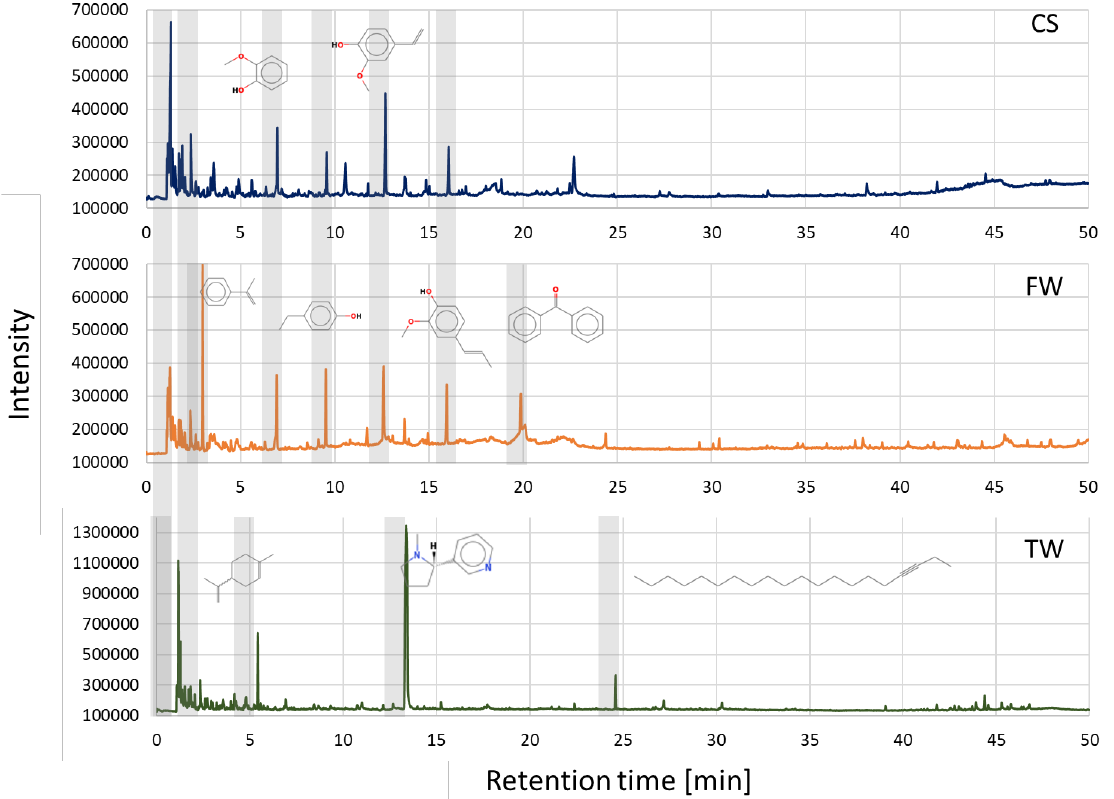
Figure 2. Pyrograms of waste biomass feedstocks CS, FW, and TW were obtained at 600 °C. Py-GC-MS analysis of the studied waste biomass feedstocks at 600 °C showed a distribution of chemical compounds (Table 3). The amount of possibly generated liquid prod- uct components varied depending on biomass type. Table 3. Chemical compound distribution determined by Py-GC-MS analysis (area%) of waste bio- mass feedstocks (CS, TW, and FW).